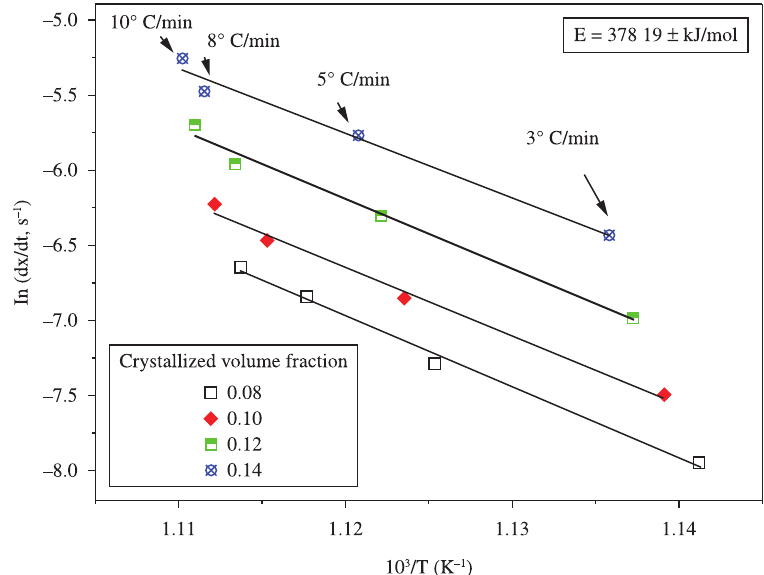
Figure 4. ln( dx/dt ) as a function of inverse temperature for the indicated crystallized volume fractions. The straight lines have been displaced on the y axis for clarity. Therefore, values of dx/dt refer only to the crystalized volume fraction of 0.08. Note that for each crystallized volume fraction, different points were obtained at a different heating